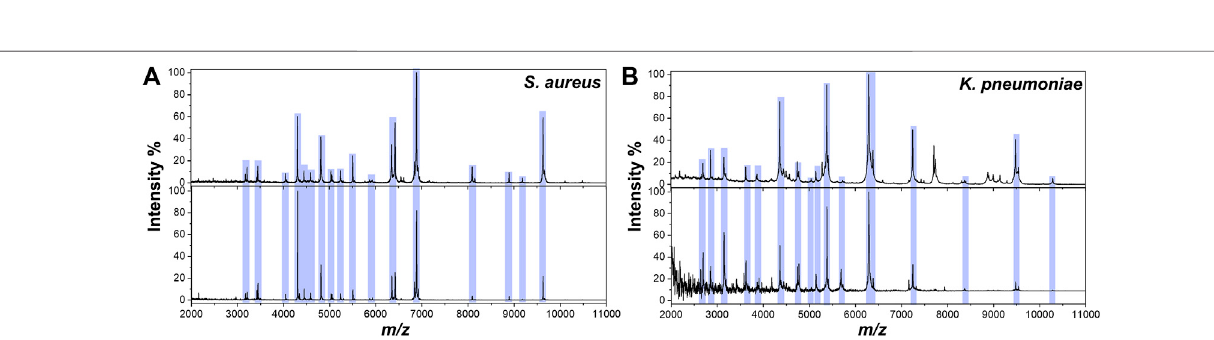
Figure 4 . The mass spectra of the bacteria in the wound swab matched Vibrio alginolyticus ( V. alginolyticus ), a common pathogenic bacteria of numerous aquatic animals that is widely present in the sea, with an average score of 2.15 ( Table 1 ). The fl uid sample was also identi fi ed as V. alginolyticus , with an average score of 2.31 ( Table 1 ). Thus, these scores indicated that the identi fi cation results were reliable at the species level. The LB media of the control group keep the clear liquid phase, and the identi fi cation results by the